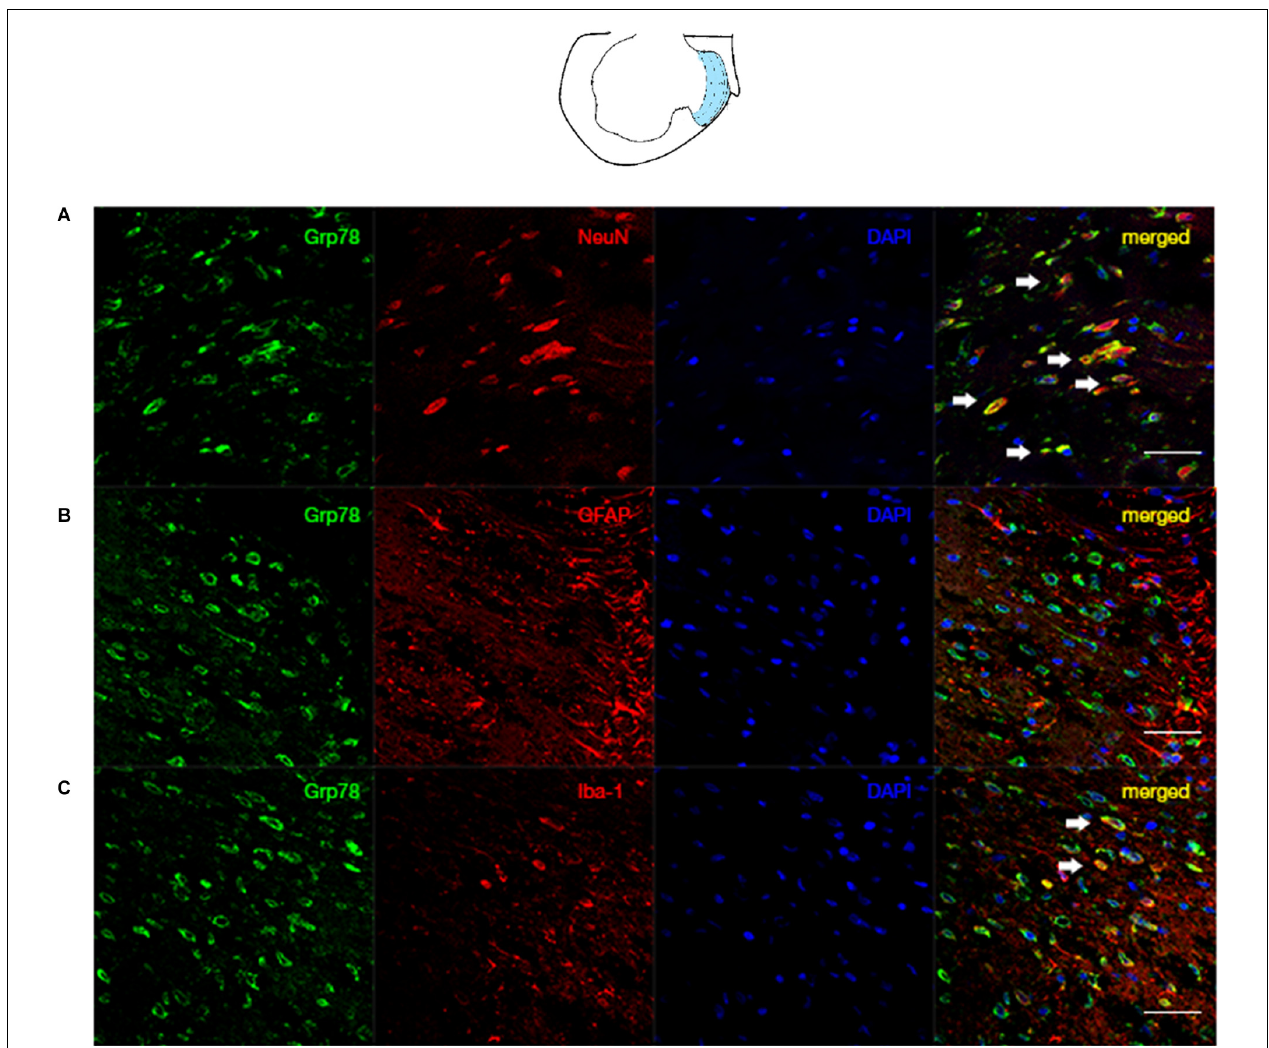
FIGURE 3 | Co-localization of Grp78 with NeuN/GFAP/Iba in the ipsilateral spinal dorsal horn of SNL rats. The laminae I-III was illustrated by the blue zone in the ipsilateralL5 atlas. (A) Confocal immunofluorescence of Grp78 and NeuN (neuron marker) in laminae I-III of SNL rats at L5 level. (B) Confocal immunofluorescence of Grp78 and GFAP (astrocyte marker) in laminae I-III of SNL rats at L5 level. (C) Confocal immunofluorescence of Grp78 and Iba (microglia marker) in laminae I-III of SNL rats at L5 level. N = 6 rats per group. Scale bar = 50 µ m.